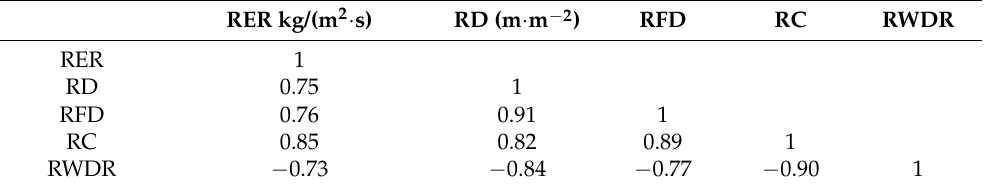
Table 1. Correlation analysis between rill erosion rate and four rill morphology